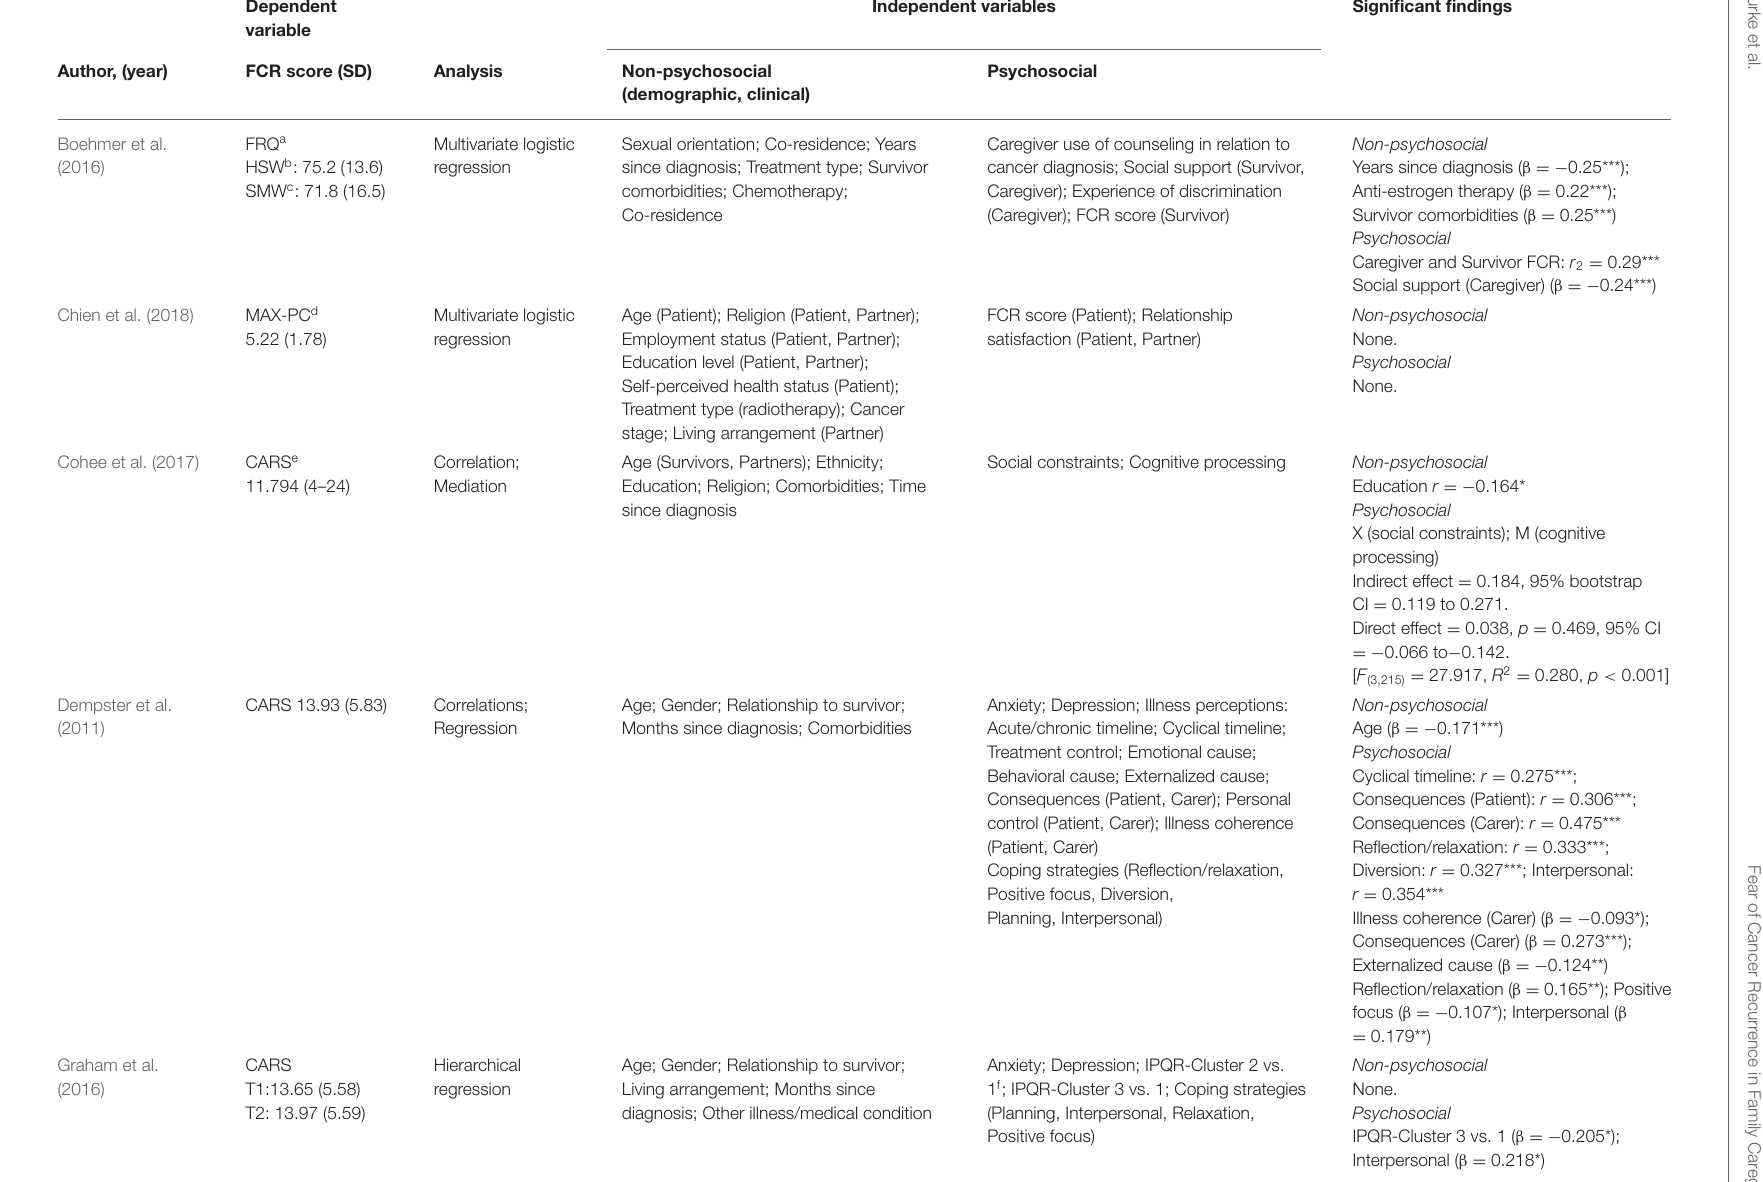
TABLE 4 | Main study